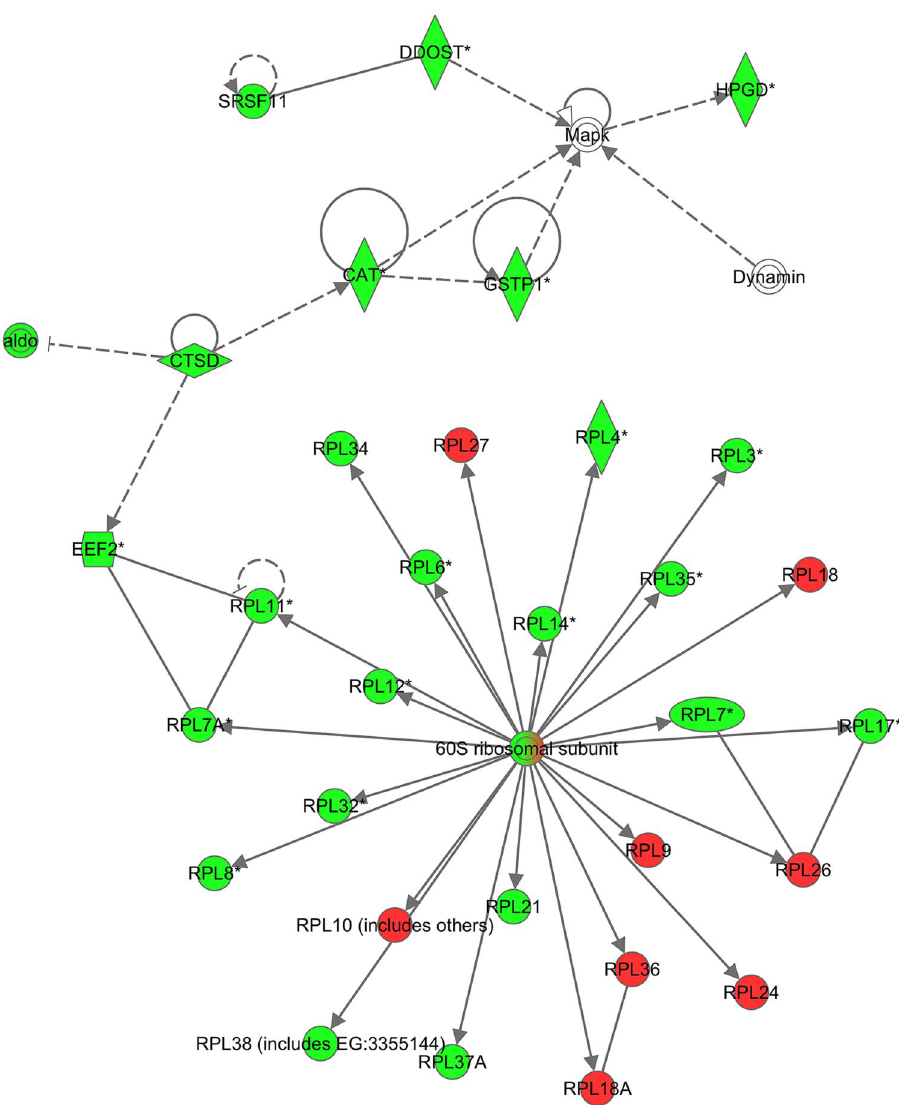
Figure 3. The highest scored network in Ingenuity Pathway Analysis (IPA) in liver of rainbow trout fed the unsupplementary vitamin and mineral Diet U. Arrows indicate direct (solid) and indirect (dashed) relation between molecules. The red color indicates up regulation and green indicates down regulation. The colorless molecules are molecules added by IPA for network generation and are not among the submitted genes from next generation sequencing and RT-qPCR data.